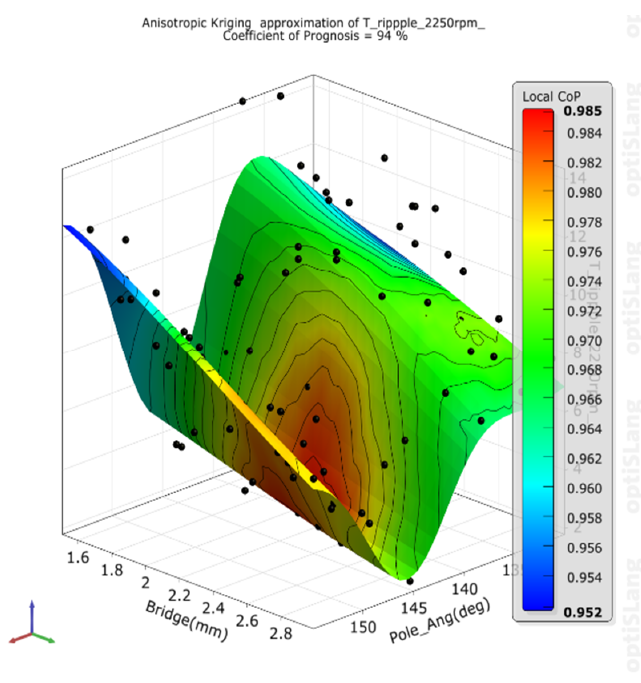
Figure 5. The surface response of rated torque ripple when CoP = 94%.